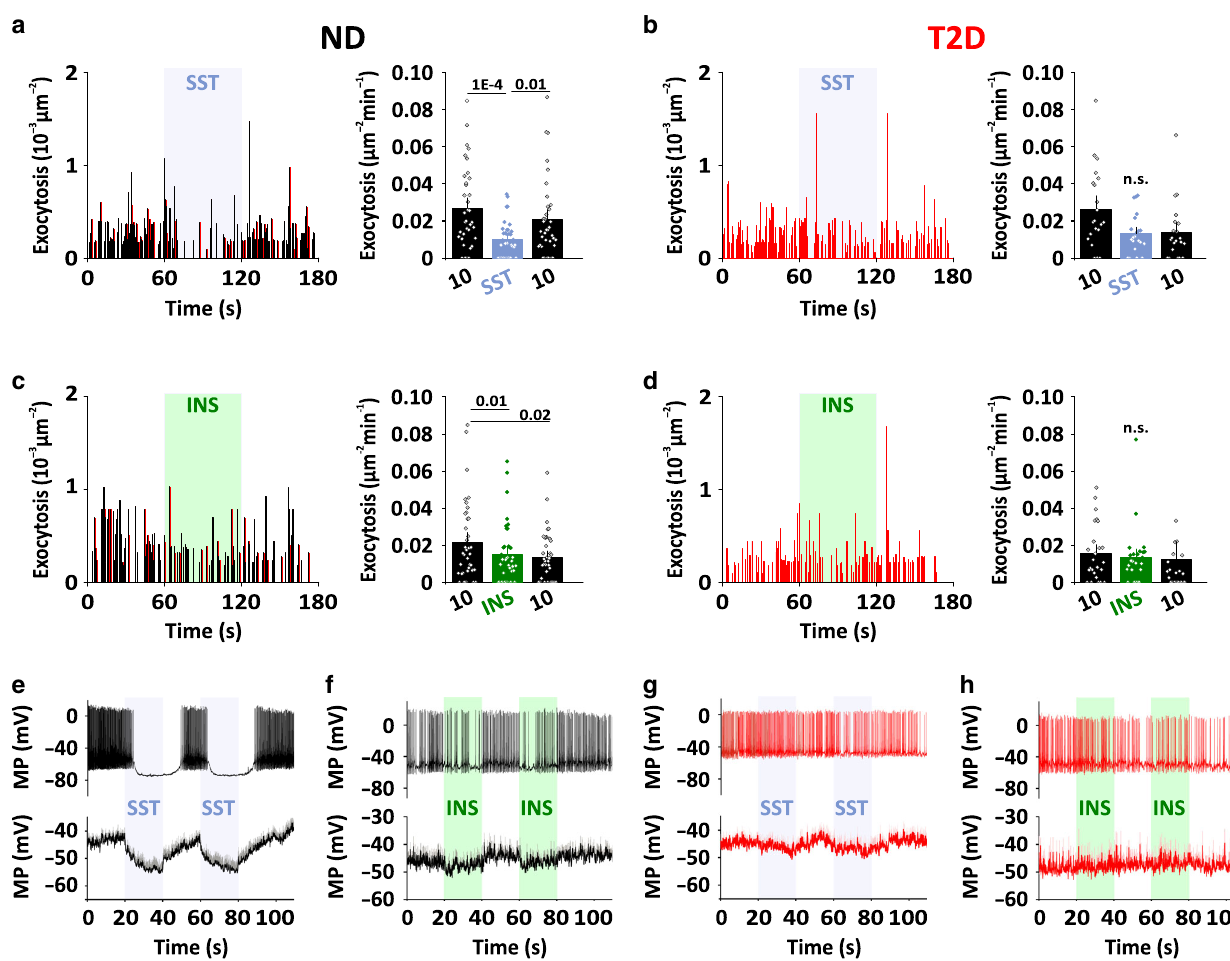
Fig. 6 Time course of paracrine inhibition in dispersed α -cells. a Time course of spontaneous exocytosis for a representative ND α -cell bathed in 10 mM glucose (black) and challenged with somatostatin during the indicated interval (SST, 400 nM; left, blue bar). Bars to the right show quanti fi cation of average exocytosis during the three time periods of the experiment (36 cells/6 donors). Data are presented as mean values ±SEM. In a – d , signi fi cant differences are indicated with p -values (one-way ANOVA, Fisher posthoc test). b As in a , but for T2D α -cells (38 cells/6 donors). c , d As in b – e , but challenged with insulin (INS, 100 nM, green bar). 21 cells/4 ND donors and 25 cells/3 T2D donors. e , f Example (upper) and average (lower) membrane potential recording in dispersed ND α -cells bathed in 10 mM glucose. Somatostatin (SST, 400 nM, 17 cells/4 donors, blue shading in e ) or insulin (INS, 100 nM, 25 cells/6 donors, green shading in f ) were applied during the indicated time interval. g , h as in e , f , but for dispersed T2D α -cells (11 cells/2 donors in G; 13 cells/4 donors in h